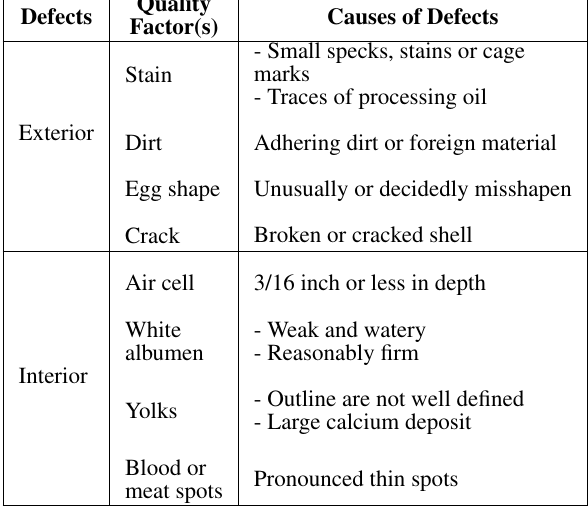
Table 1. Exterior and Interior Defects of